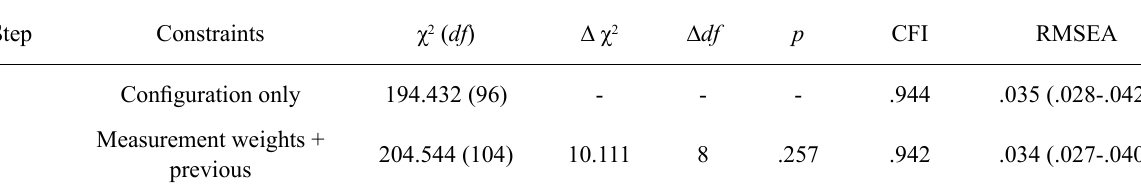
Summary of Results for Measurement Invariance Testing Across Gender